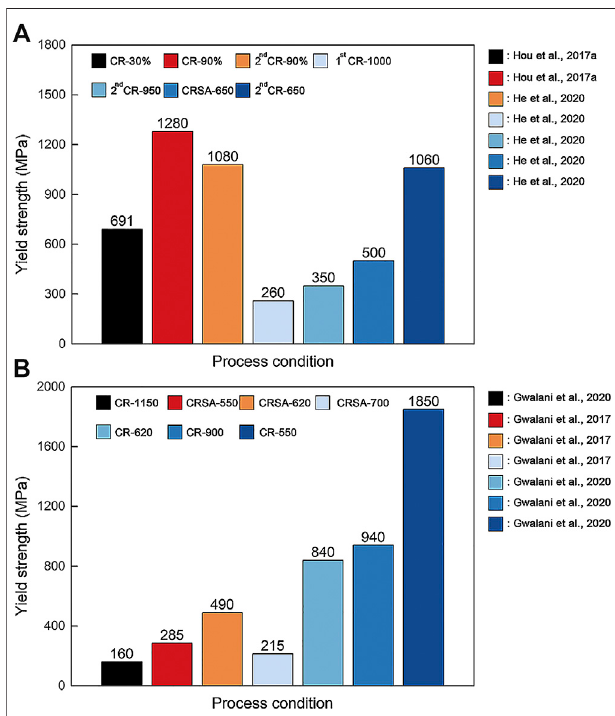
FIGURE 6 | Comparison of yield strength of (A) Al 0.25 CoCrFeNi, and (B) Al 0.3 CoCrFeNi alloys under different thermal-mechanical processing conditions (Hou et al., 2017a; Gwalani et al., 2017; Gwalani et al., 2020; He et al.,